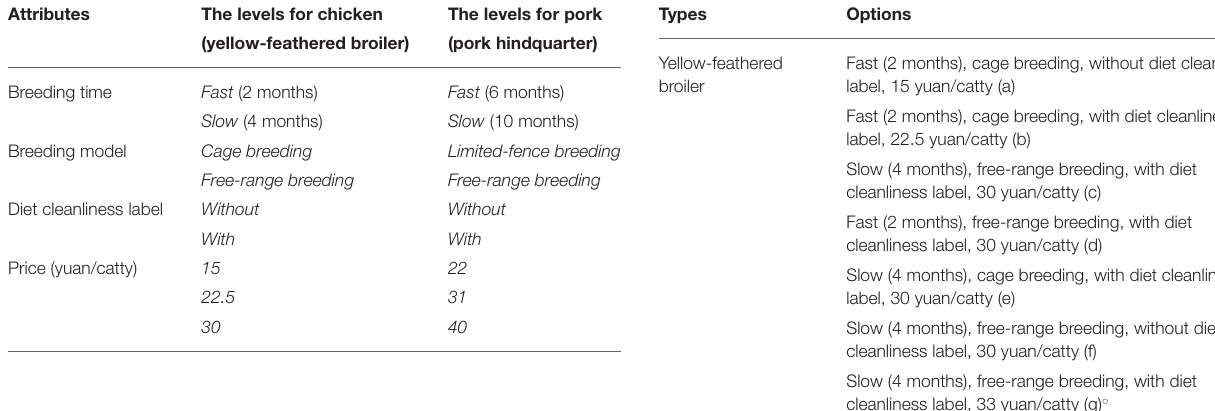
TABLE 1 | The setting of the attributes and their corresponding levels. Attributes The levels for chicken The levels for pork (yellow-feathered broiler) (pork hindquarter) Breeding time Fast (2 months) Fast (6 months) Slow (4 months) Slow (10 months) Breeding model Cage breeding Limited-fence breeding Free-range breeding Free-range breeding